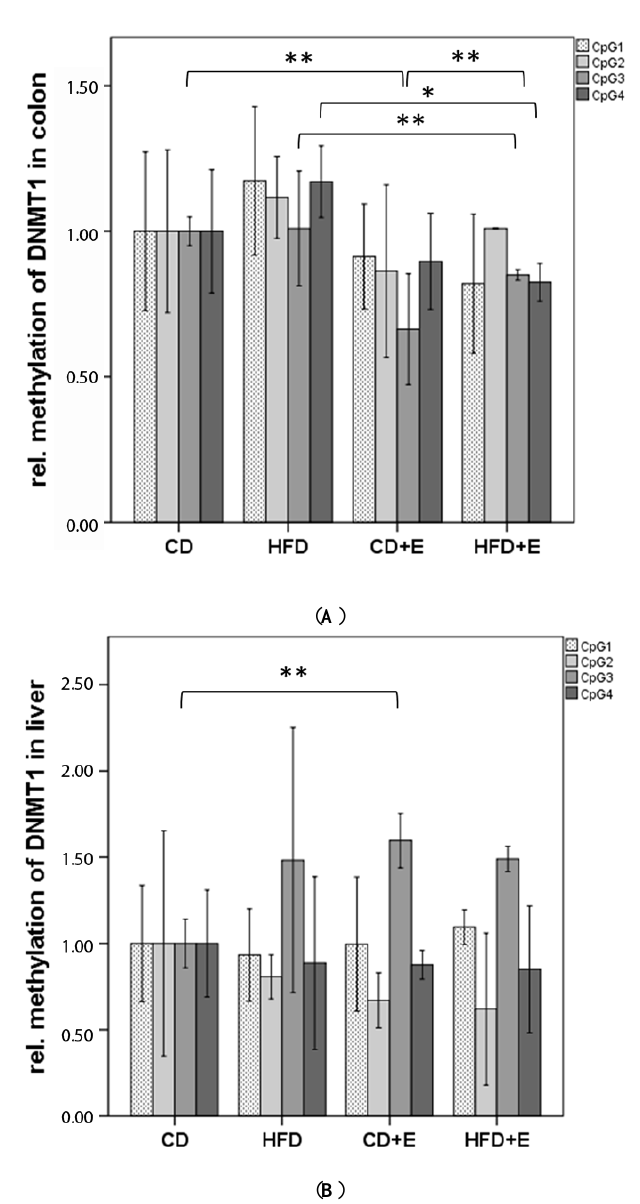
Figure 4. Relative CpG methylation status in promoter region of Dnmt1 in colon ( A ) and liver ( B ) of C57BL/6J male mice ( n = 15). All methylation data are relative to CD. The error bar represents a 95% confidence interval. (CD = control diet; HFD = high fat diet; CD + E = control diet plus vitamin E; HFD + E = high fat diet plus vitamin E; * p -value ≤ 0.05; ** p -value ≤